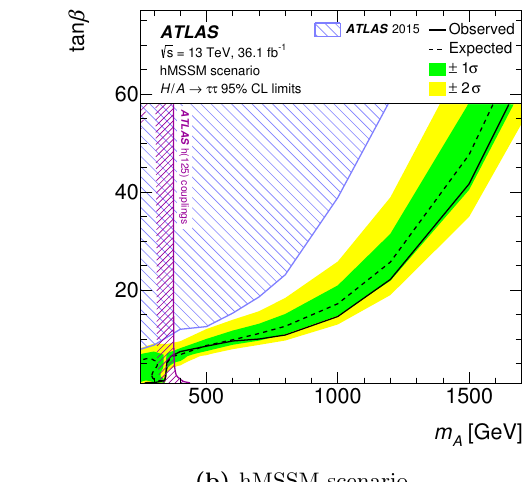
scenario, dashed lines of constant m h